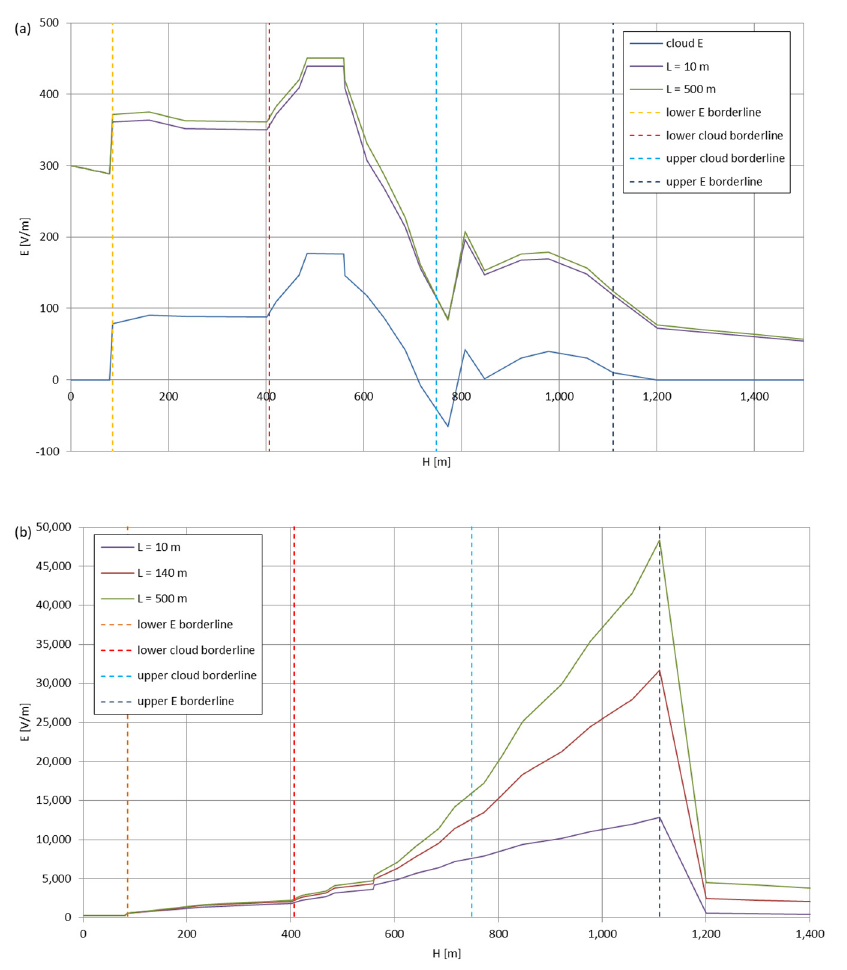
Figure 12. Maximum electric field strengths around the wire antenna passing through Stratocumulus cloud polarized positively: ( a ) ‘static’ case, with the ‘140 m’ data set omitted to enhance curve visibility; and ( b ) ‘dynamic’ case.